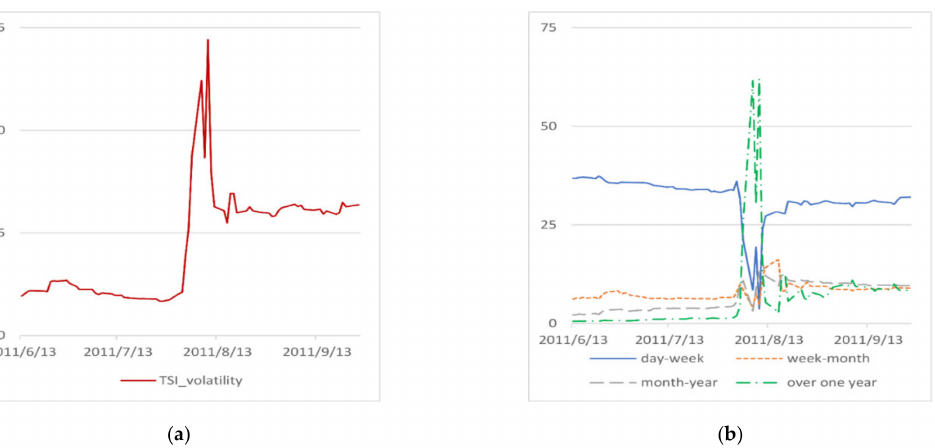
Figure 5. Total spillover of the price volatility system during the European debt crisis. ( a ) total volatility spillover. ( b ) frequency decomposition of volatility